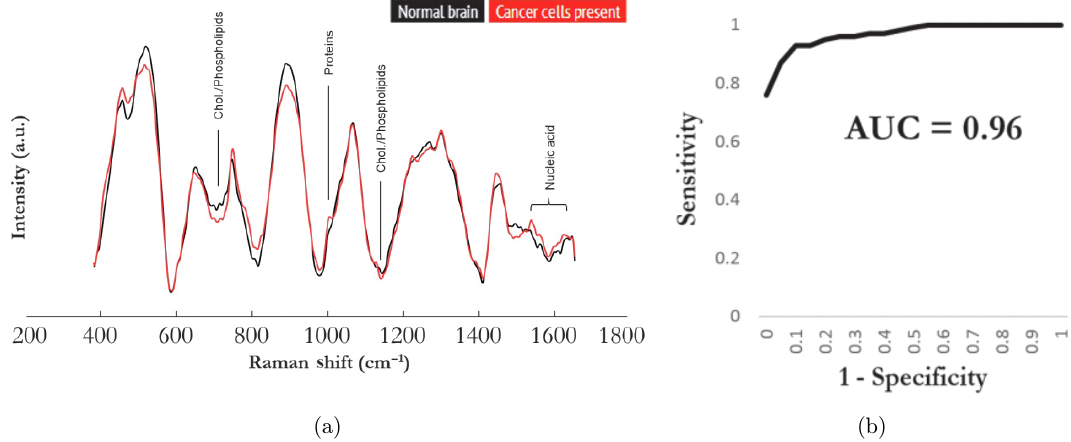
Fig. 1. Raman spectra for discrimination of cancer tissue. (a) Average Raman spectra of in vivo measurements for normal brain (all 66 spectra averaged) and tissue containing glioma cancer cells (all 95 spectra averaged). Corresponding molecular contributors are identi¯ed for the most signi¯cant di®erences between the spectra for normal and cancer tissues. Chol. ¼ cholesterol. (b) Receiver operating characteristic curve analysis of in vivo detection of glioma based on Raman spectroscopy, generated using the boosted trees classi¯cation method. AUC ¼ area under the curve. From Ref. 41. Reprinted with permission from